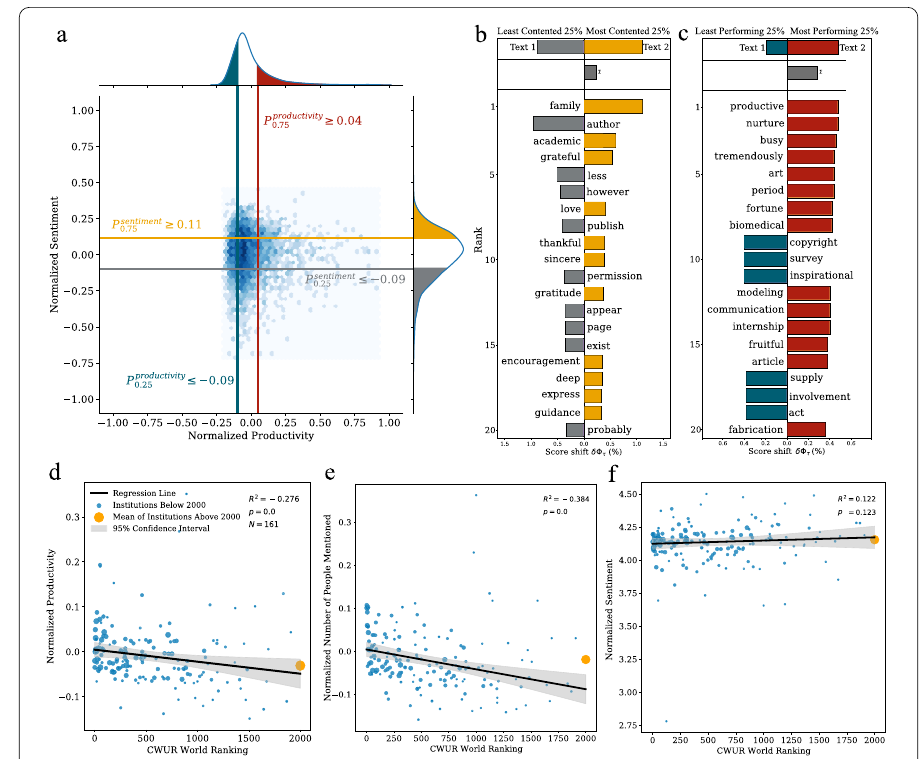
Figure 4 Determinants of academic productivity and linguistic differences between extreme cases. Sentiment and productivity levels of students were normalized based on their disciplines and genders ( a ). Word usage differences are quantified by JS Divergence scores and compared students at the first and third quartiles based on normalized sentiment and productivity ( b , c ). Relationship between CWUR World rankings and normalized productivity levels ( d ). Relationship between CWUR World rankings and normalized number of mentions in acknowledgements ( e ). Relationship between CWUR World rankings and normalized sentiment scores in acknowledgements ( f ). R-squared values denote Spearman’s rank correlation. Size of blue dots is proportional to the number of theses from these